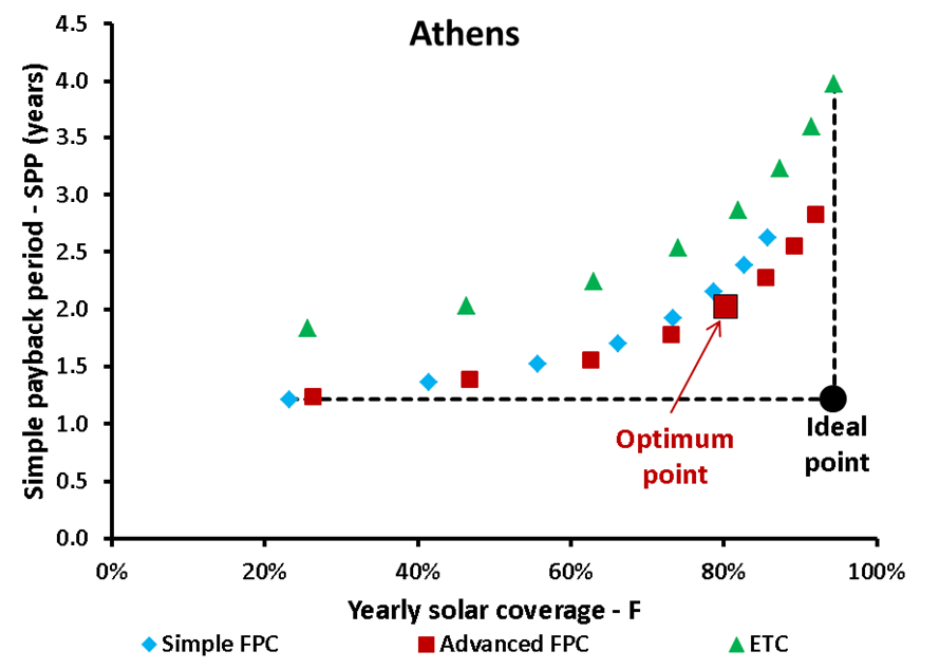
Figure 29. Multi-objective optimization for the Athens city — Zone B.